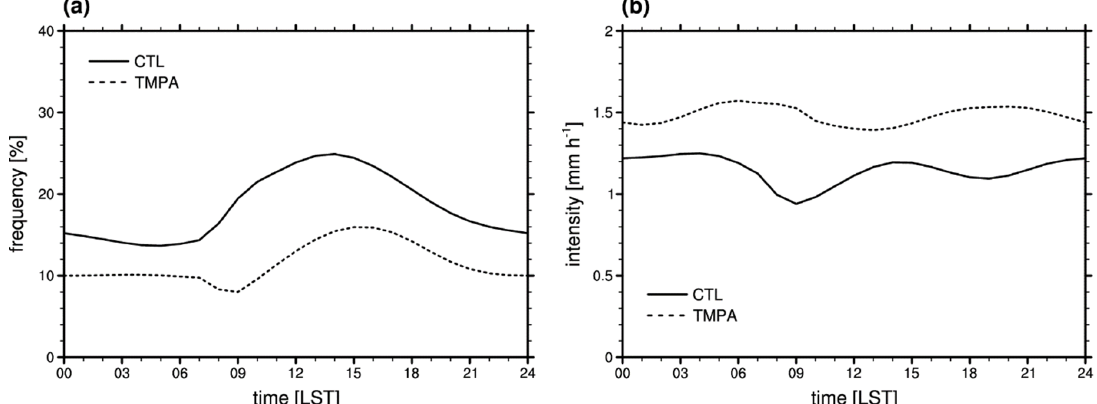
Figure 3. Diurnal variations of convective (solid line) and non-convective (dashed line) precipitation rates (mm h − 1 ) averaged for JJA 2006 over the East Asian land area from the CTL experiment.